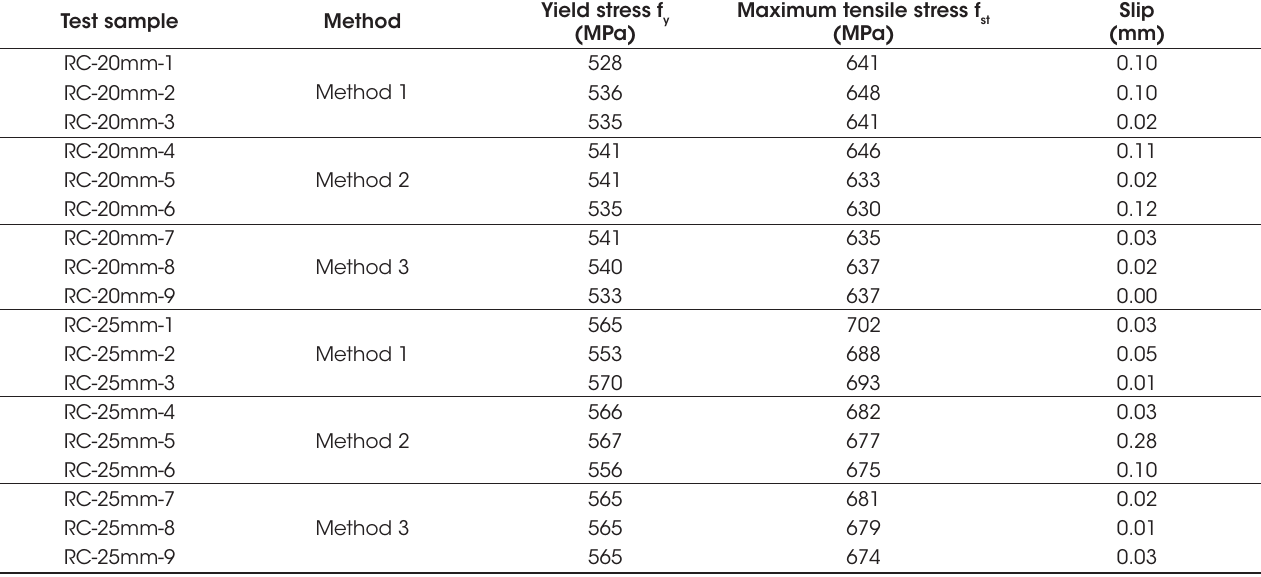
Results of performance tests on steel bars with taper-threaded mechanical splices